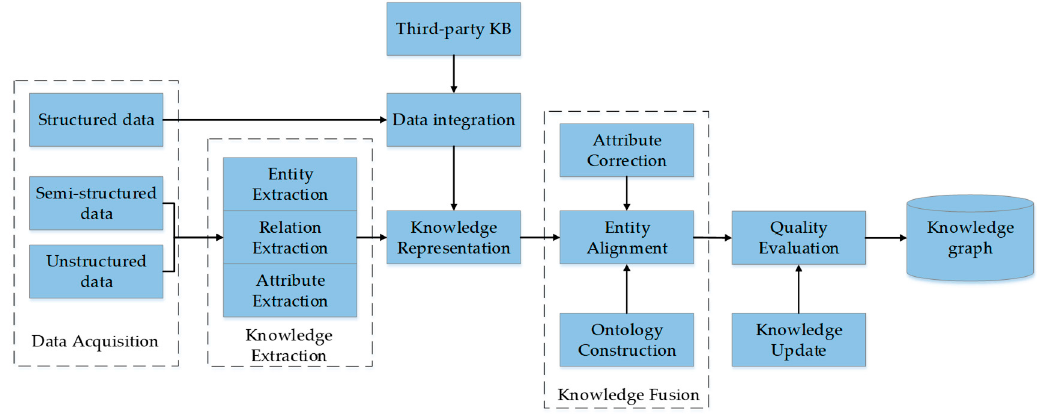
Figure 1. Construction framework of Chinese ancient historical and cultural knowledge graph.